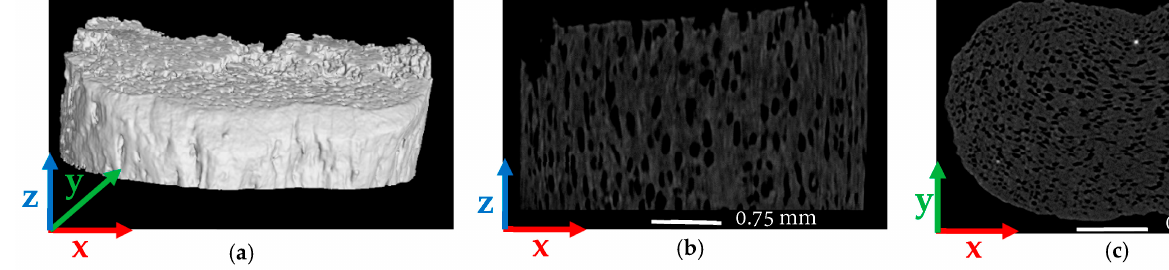
Figure 3. Void volume fraction within the different directions of a SCF/ABS pellet: ( a ) along the X- direction; ( b ) along the Y-direction; ( c ) along the Z-direction. Results from our SCF/ABS pellet appear in Figures 2 and 3. As shown in Figure 2b voids within the SCF/ABS pellet were elongated in the Z-direction and were more rounded in the cross-X normal to the print direction as shown in Figure 2c. Moreover, Figure 2c illustrates that large voids were more centrally located, and voids appeared to have a higher concentration in the center of the pellet rather than near its edge. In com- parison, Figure 3a,b shows that the volume fraction was more uniform across the width (X-direction) than through the thickness (Y-direction) and voids had a higher volume fraction in the center (having a maximum of 11.64%). The void volume fraction de-